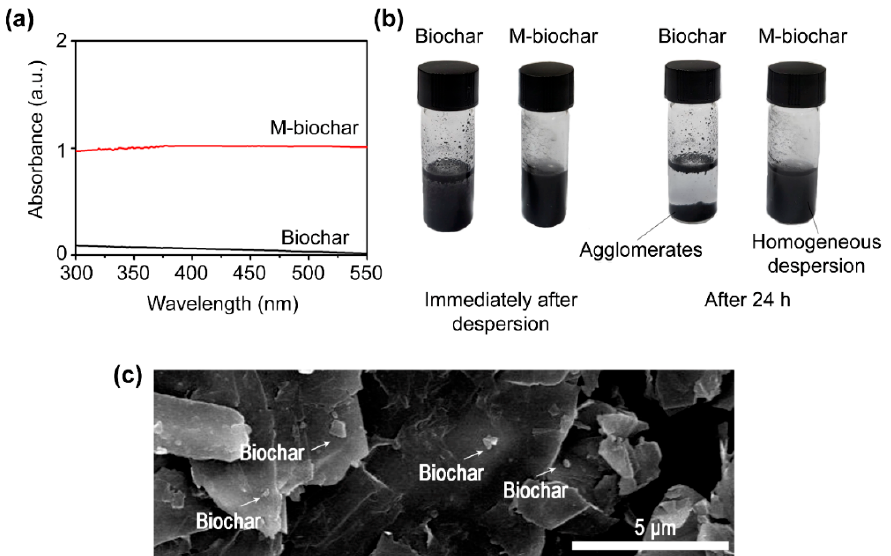
Figure 3. Dispersive properties and microstructure of the biochar in the concrete matrix: ( a ) ultraviolet-visible spectra of dispersed biochar (0.025 wt.%) and m-biochar (0.025 wt.%) in diluted water after 24 h and ( b ) their dispersion stability; ( c ) cross-sectional SEM images of 1 wt.% m-biochar-reinforced cementitious